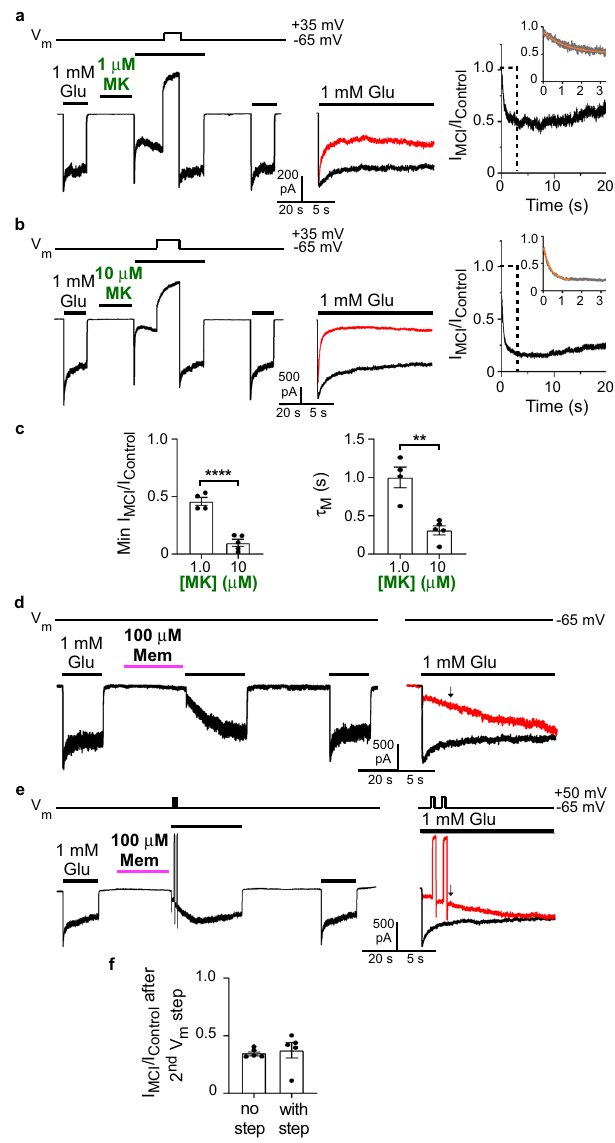
Fig. 4 Blockers transit from a reservoir of drug molecules to the NMDAR channel during MCI. a – c Measurement of [MK-801] dependence of τ M